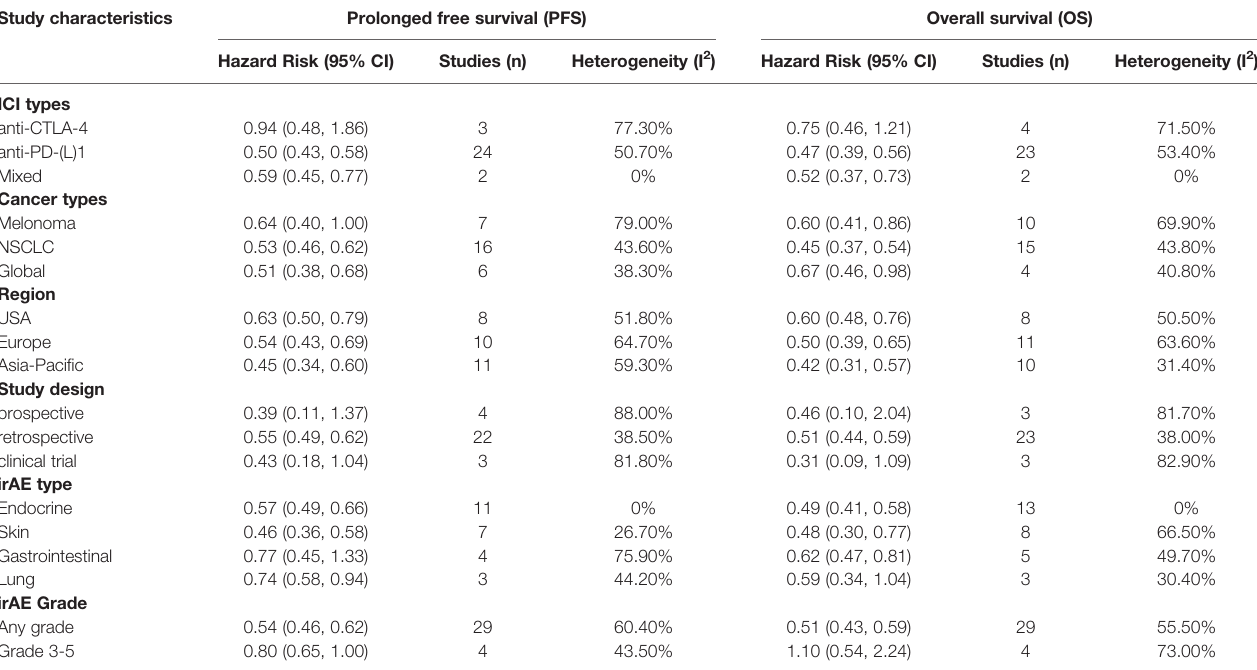
TABLE 3 | Subgroup analyses according to studies characteristics and methodology (end-points: PFS/OS). Study characteristics